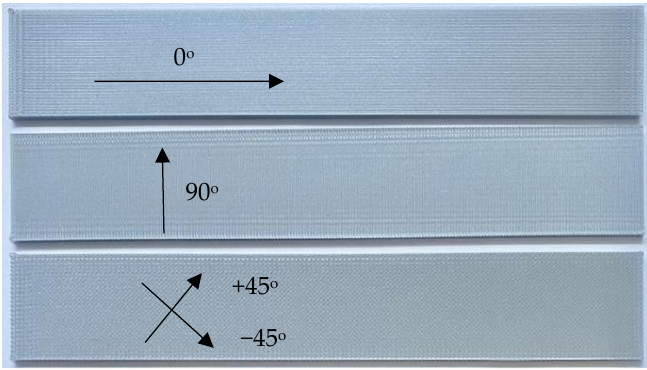
Figure 3. Test specimen different printing orientations.